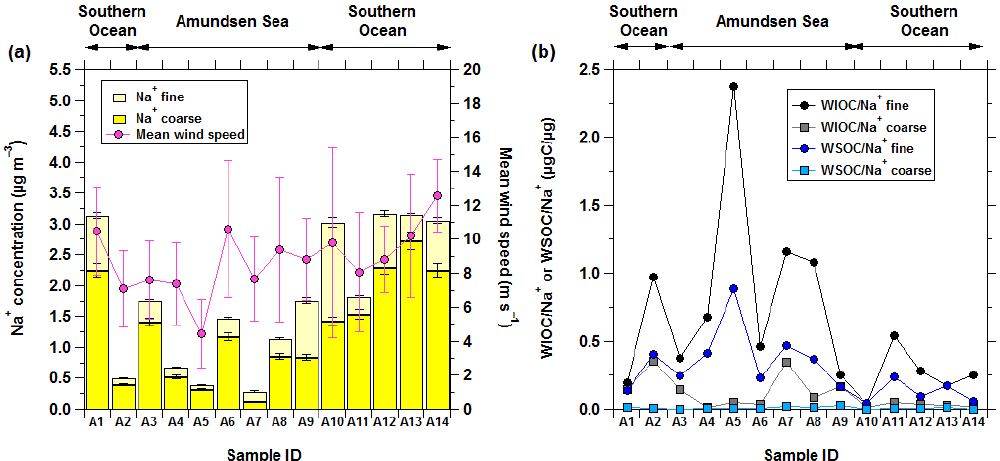
Figure 7. Concentration of Na + (a) , WIOC / Na + and WSOC / Na + ratios in both fine and coarse modes (b) against aerosol sample ID. The pink solid line with circles in (a) indicates the mean and standard deviation of wind speeds for each aerosol sampling time.